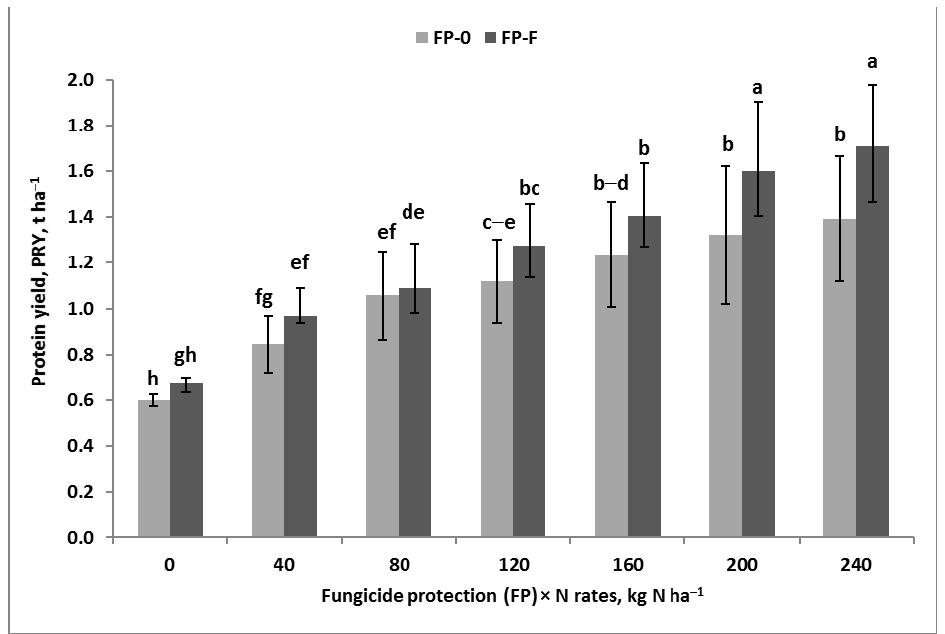
Figure 2. Effect of winter wheat protection with fungicides and rates of fertiliser nitrogen on protein yield. Similar letters in the column means a lack of significant differences using Tukey’s test; the vertical bar in the column refers to the standard error of the mean.